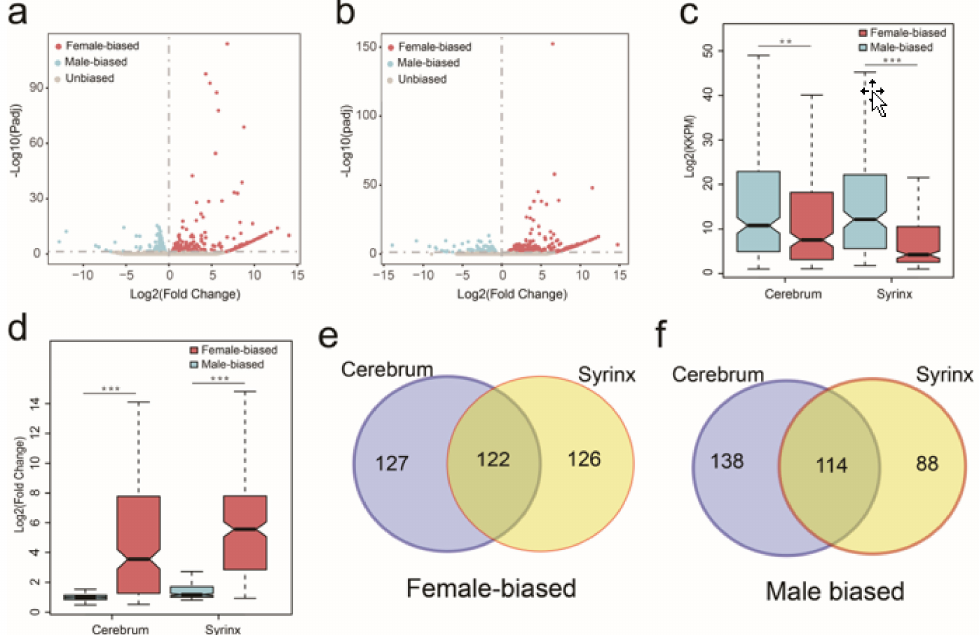
Figure 1. The expression characteristics of sex-biased genes in Chinese hwamei cerebrum and syrinx tissue. The volcano plots show sex-biased gene expression in the cerebrum ( a ) and syrinx ( b ) tissue and the red dots represent the female-biased genes; the light blue dots indicate the male-biased genes, and the gray represents the unbiased genes. Average gene expression level (FPKM) of female-biased genes in female and male-biased genes in male ( c ). Differences in expression magnitude (Fold change) between female-biased and male-biased genes ( d ). Venn diagrams wing the number of female- biased ( e ) and male-biased genes ( f ) in cerebrum and syrinx. Significant difference is represented by *, using Wilcoxon rank sum test, * p < 0.05, ** p < 0.01, *** p <